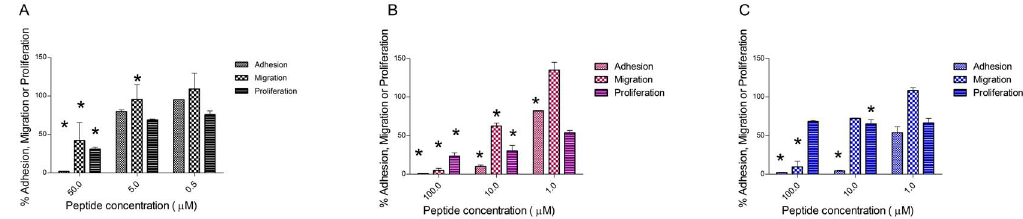
Figure 1. Invitro inhibition activity of the peptide on vascular endothelial cells, tumor cells and lymphatic endothelial cells. Inhibition of migration (checkered), adhesion (hashed) and proliferation (horizontally hashed) relative to the vehicle control, as a result of incubation of HUVEC (A), LEC (B), and tumor cells (C) with different concentrations of SP2024. Asterisks indicate statistical significance (p , 0.05) in comparison to the treatment with the lowest concentration (0.5 or 1.0 m M).